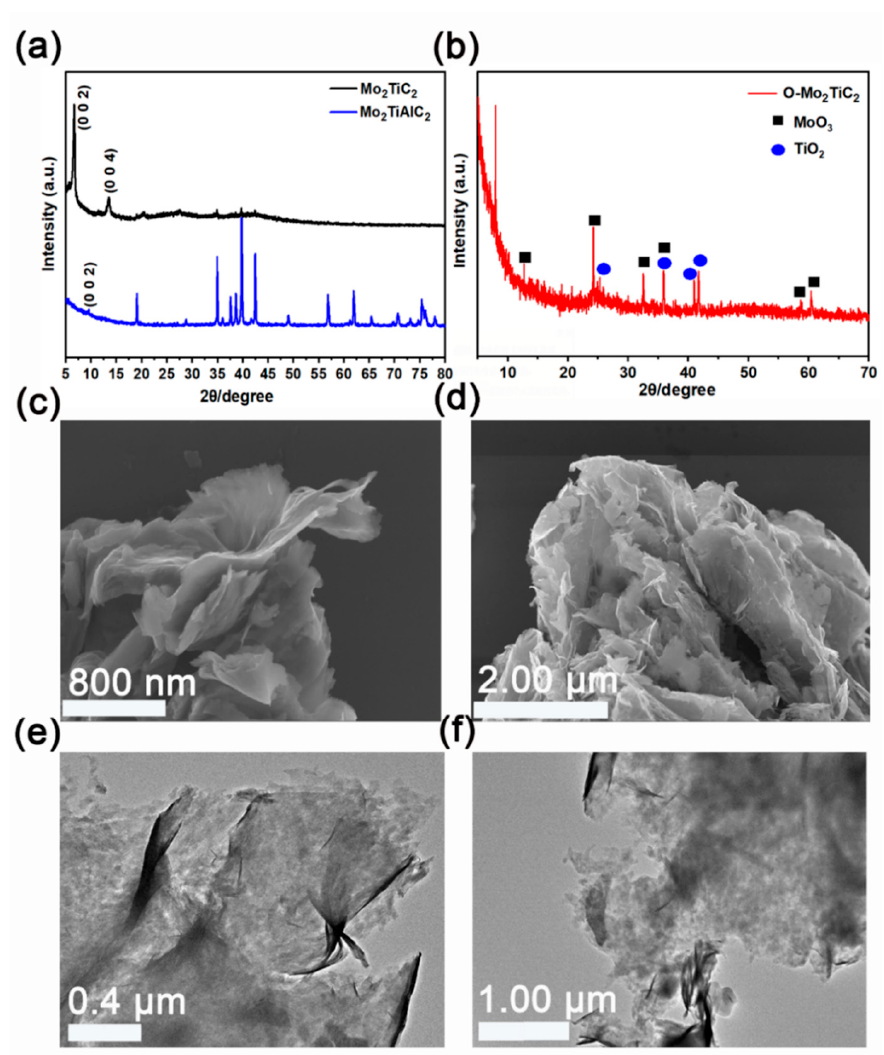
Figure 1. ( a ) XRD spectra of Mo 2 TiC 2 MXene and Mo 2 TiAlC 2 . ( b ) XRD spectra of O-Mo 2 TiC 2 . SEM images of ( c ) Mo 2 TiC 2 MXene and ( d ) O-Mo 2 TiC 2 . TEM images of ( e ) Mo 2 TiC 2 MXene and ( f ) O-Mo 2 TiC 2 .